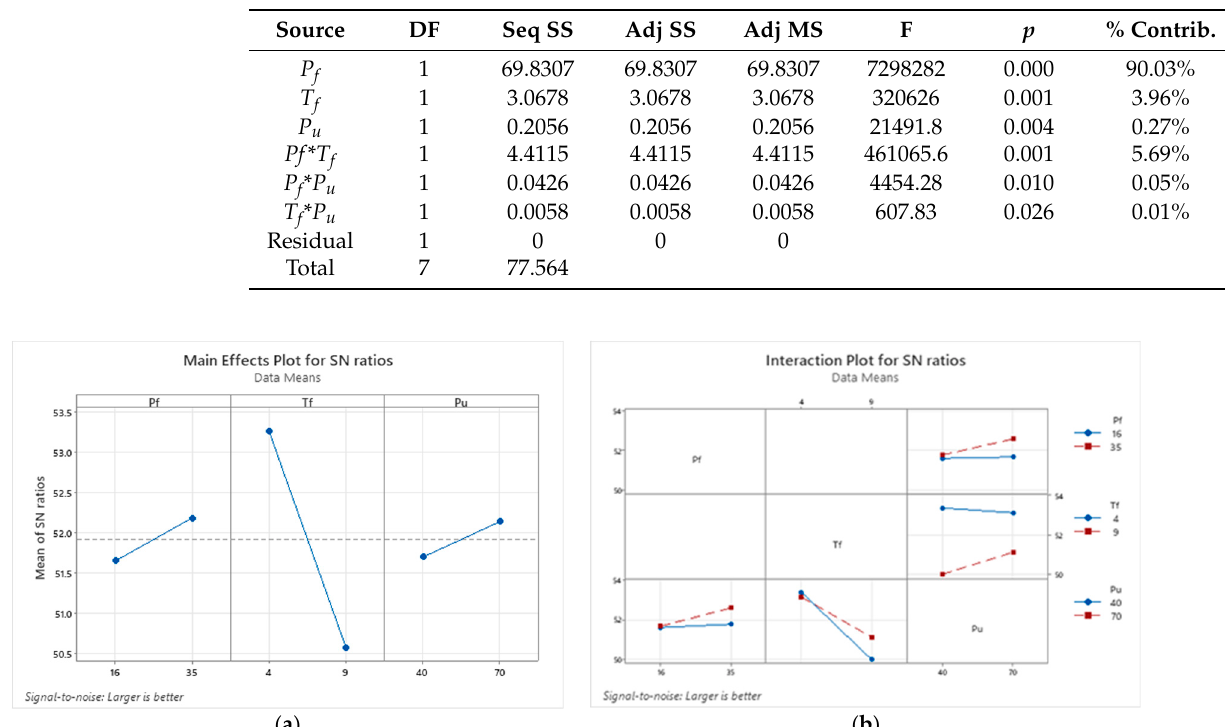
( b ) Figure 11. Medium-carbon steel–304 SS main effect ( a ) and interaction ( b ) plots for signal-to-noise ratio.